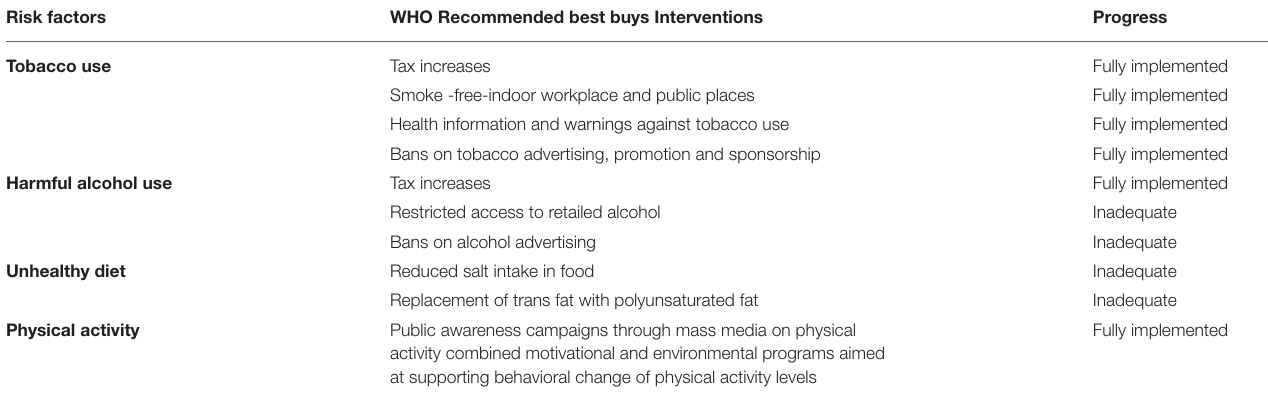
TABLE 3 | Current implementation of ‘WHO Best Buy’ Interventions in